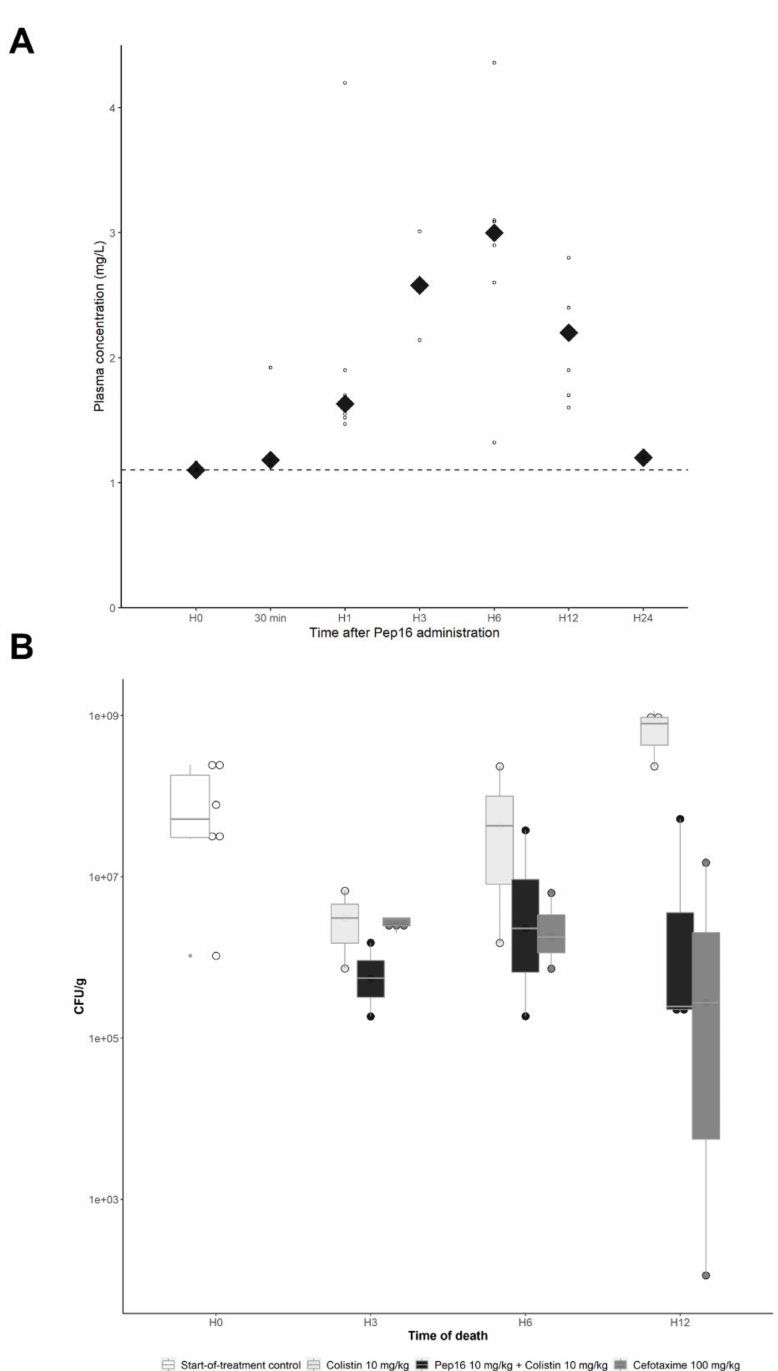
Figure 3. In vivo studies of Pep16. ( A ) Pharmacokinetics of Pep16 in mice after a single subcutaneous administration of 10 mg/kg. Each dot represents a sample, and the diamonds represent the median at each time point. One value at H12 (11.3 mg/L) is not shown on the graph, but has been integrated to determine the median. Dotted line represents the limit of detection. ( B ) Murine model of peritonitis due to CFT073-pTOPO. Bacterial counts in the spleens according to the time of death in 3 treatment groups: colistin alone, colistin + Pep16, and cefotaxime ( p = 0.002). The group treated with Pep16 10 mg/kg alone is not shown considering the high spontaneous mortality (6/8 mice). Mice that died before their planned time of death were classified as having died at the closest upcoming time